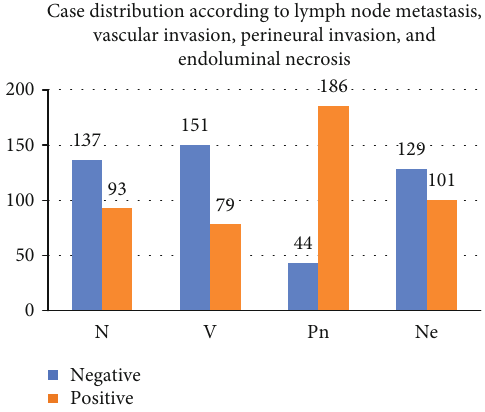
Figure 4: Distribution of lymph node metastasis (N), vascular invasion (V), perineural invasion (Pn), and endoluminal necrosis (Ne).